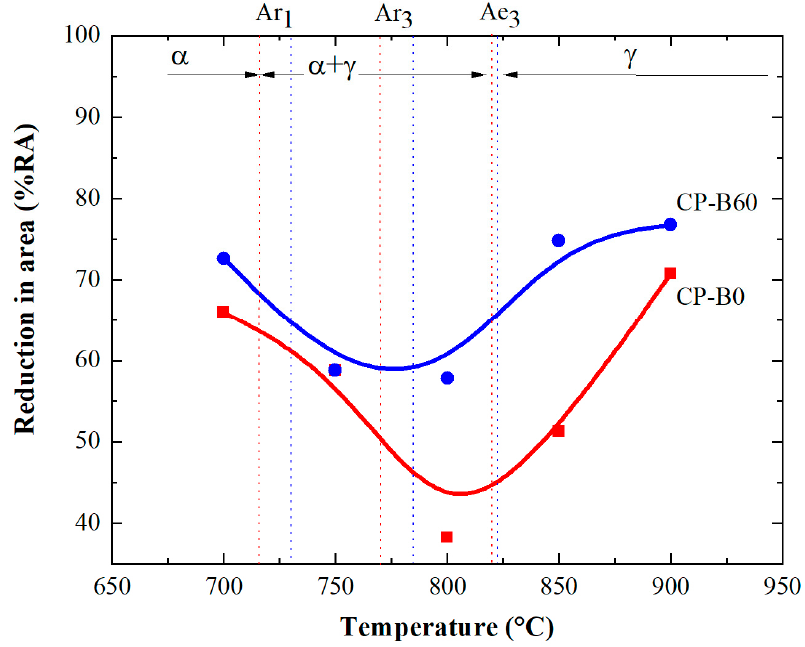
Figure 6. Hot ductility curves for the experimental advanced boron-free (CP-B0) and boron-containing (CP-B60) steels.